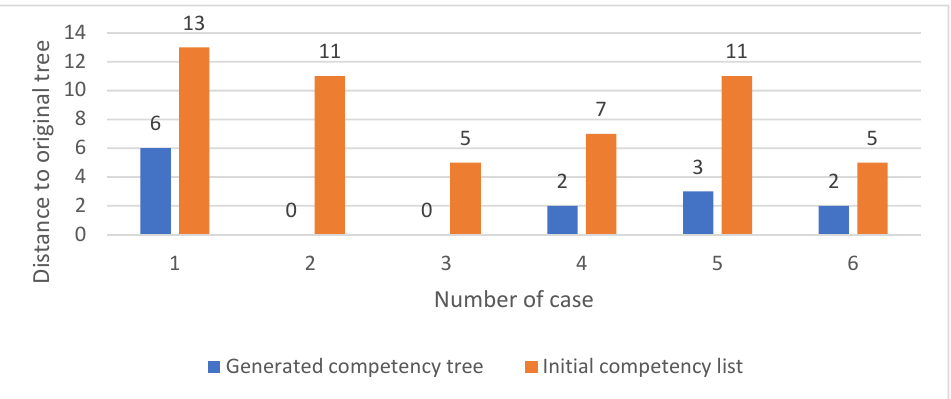
Figure 4. Comparison of distance, or steps, for node movement in the generated tree and in the initial competency list to get the full match to the original competency tree.